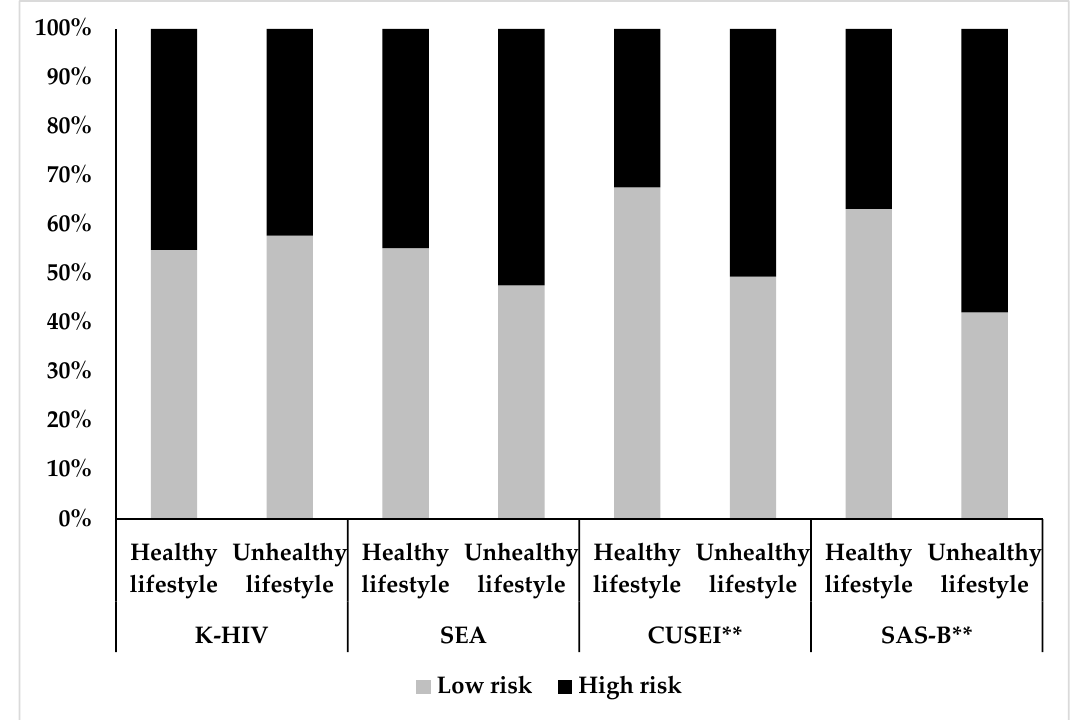
Figure 1. Risk of HIV infection based on the quality of total lifestyle. Knowledge about HIV (K-HIV), Self-Efficacy and Attitudes (SEA), Condom Use Intentions (CUSEI), Safe Sexual Behavior (SAS-B). Significant differences ** p < 0.01.